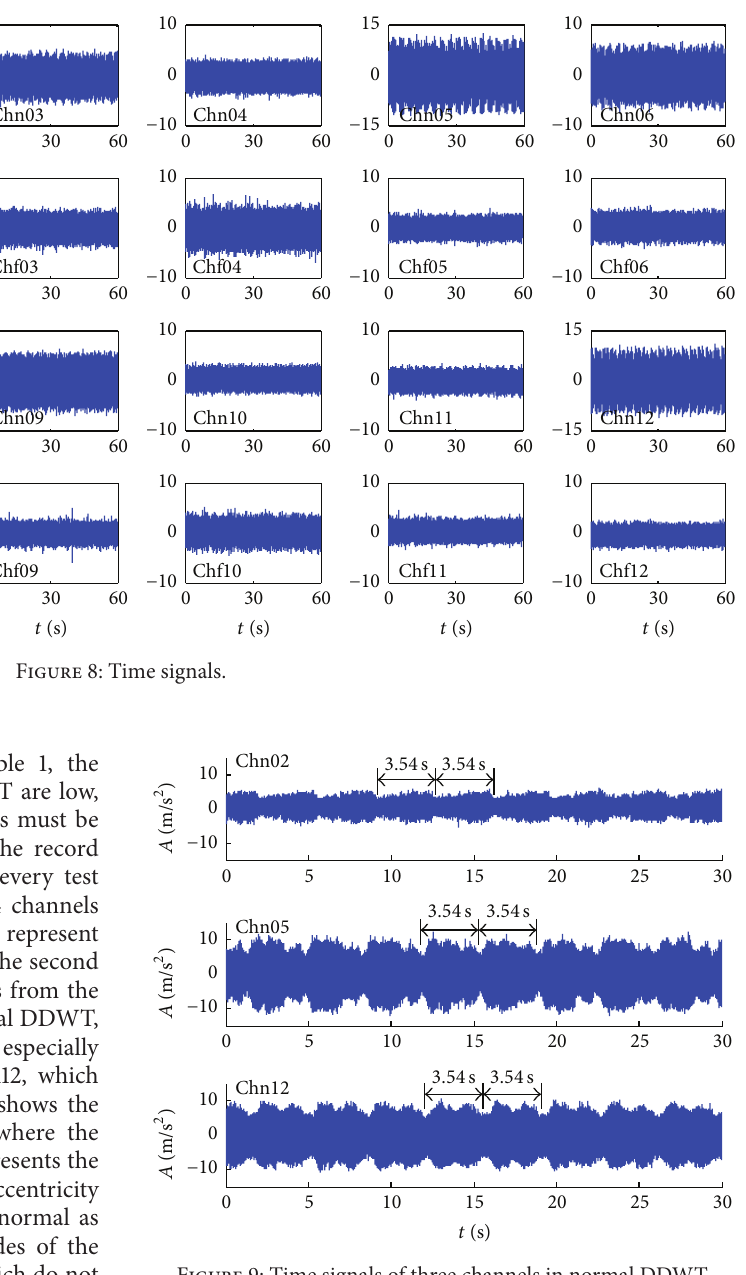
Figure 9: Time signals of three channels in normal